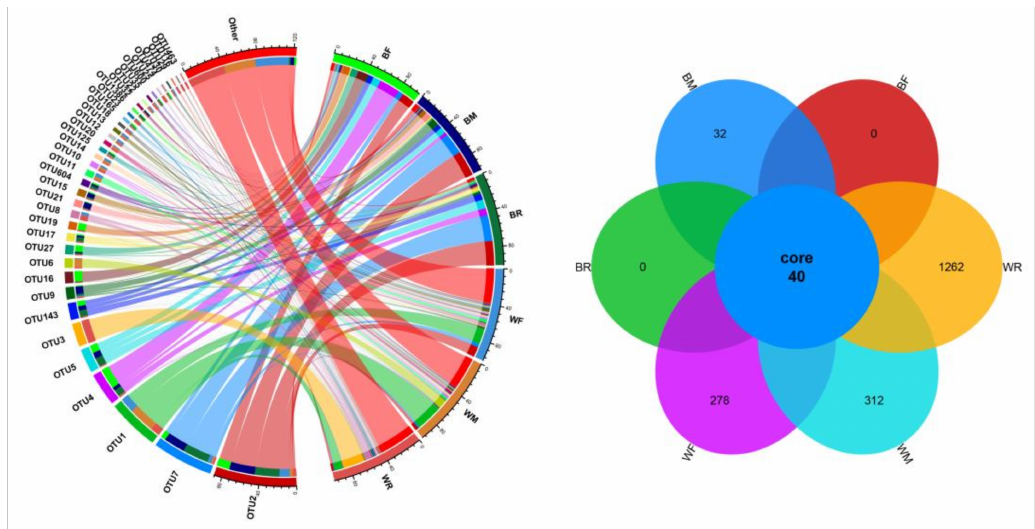
Figure 1. Hierarchical cluster analysis and Venn diagram at the OTU level of gut microbiota in cultivated and wild Mastacembelus armatus . The hierarchical cluster analysis and Venn diagram were constructed using R 3.5.0 [59] for